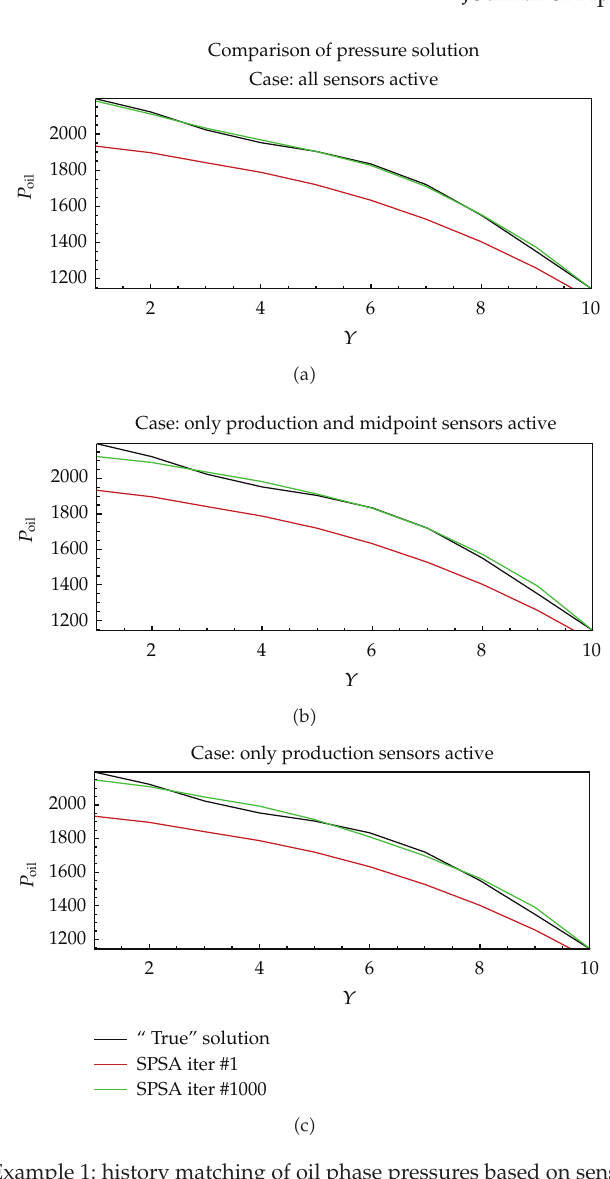
Figure 2: Example 1: history matching of oil phase pressures based on sensor